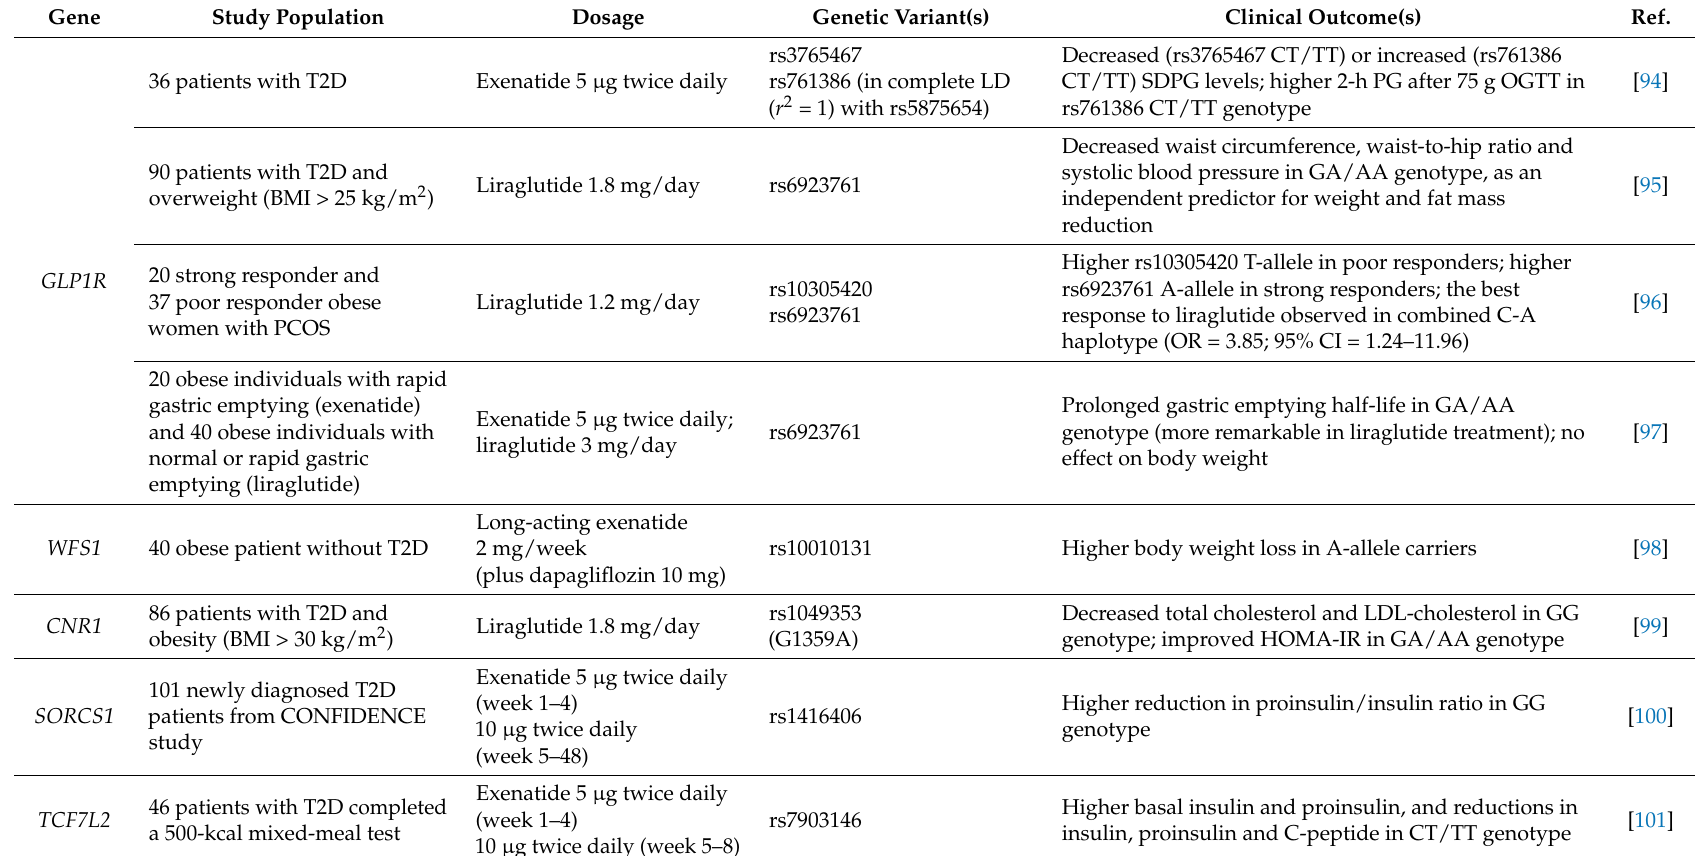
Table 3. Genes associated with responses to GLP-1 receptor